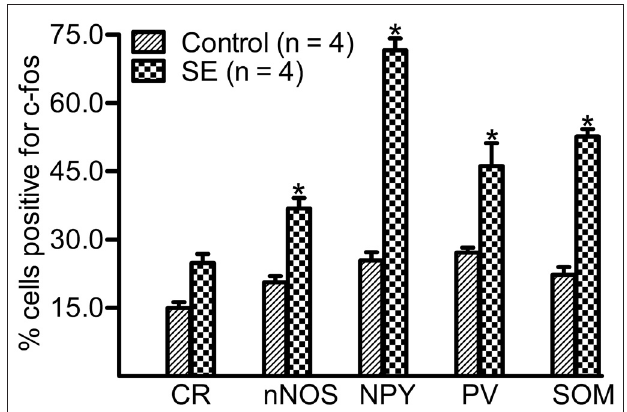
FIGURE 5 | Percentage of neurochemically defined hilar cells that express c-fos more than 10 weeks after SE . SE was induced by an intraperitoneal injection of pilocarpine. The controls (Control) received equivalent volume of normal saline instead of pilocarpine solution. Sections prepared were double-stained with anti-c-fos and an anti-interneuron marker and were scanned with a Zeiss LSM780 confocal microscopy by using a 20 × lens. Cells expressing c-fos in the marker-positive population were counted in three sections per rat by darkening hilar background stains. Data are statistically compared with Bonferroni post hoc test following 2-way ANOVA. Each data point is from four animals. ∗ p < 0.01, compared to the